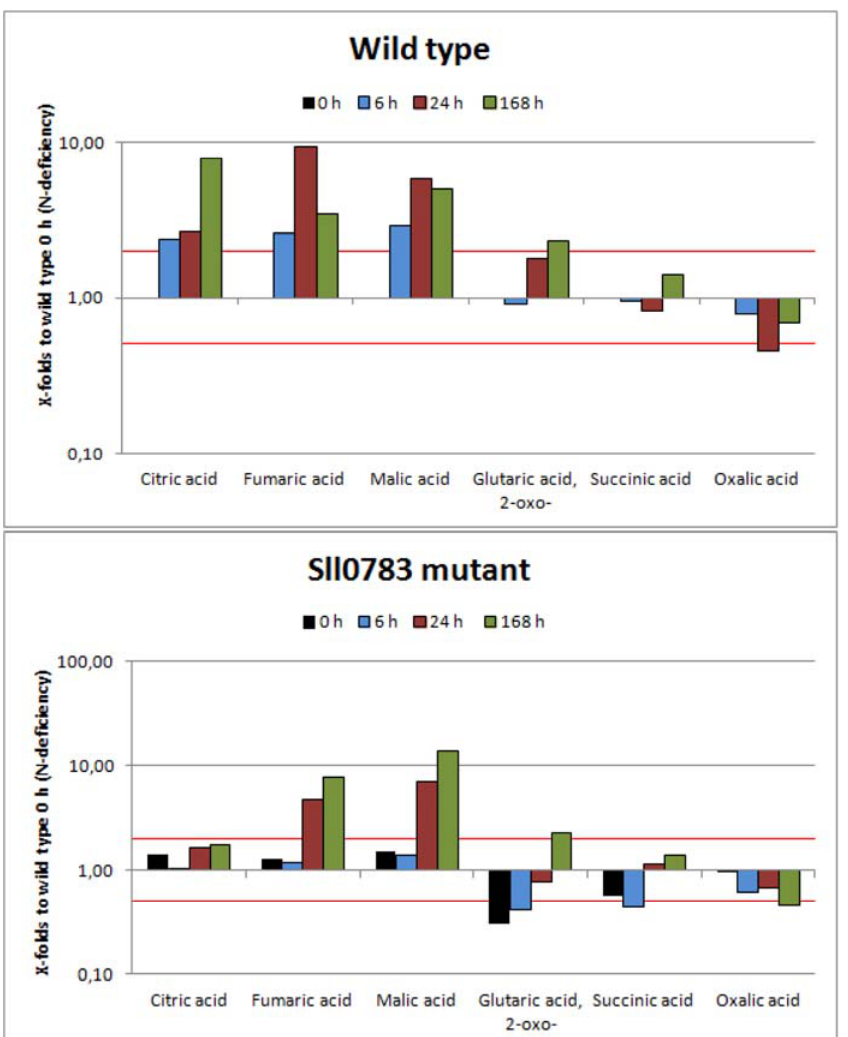
Figure 3. Levels of tri- and dicarboxylic acid intermediates in wild type and the sll0783 mutant throughout nitrogen starvation. Black bars represent the metabolites levels prior to nitrogen starvation (0 h), cyan bars represent values obtained 6 h, red bars 24 h and green bars 168 h after nitrogen starvation has been induced. All bars represent x-fold changes in metabolite levels compared to the level in wild type at time point 0 h. The red lines mark the values 2 and 0.5. Values above or below these lines represent statistically significant changes of metabolite levels when compared to wild type at time point 0